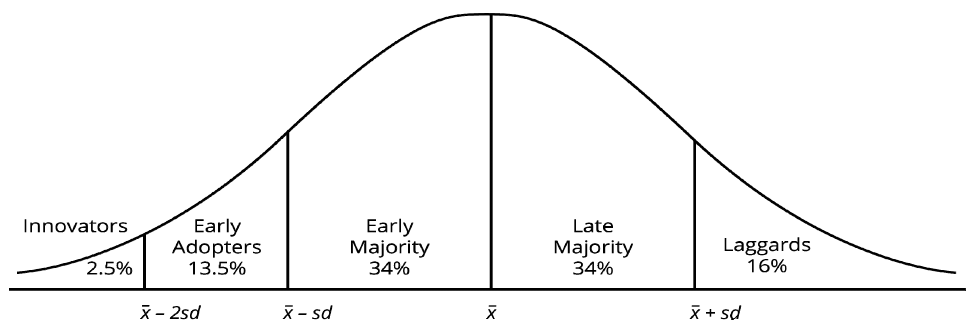
Figure 1. Adopter categorization on the basis of innovativeness (adapted from [15]).